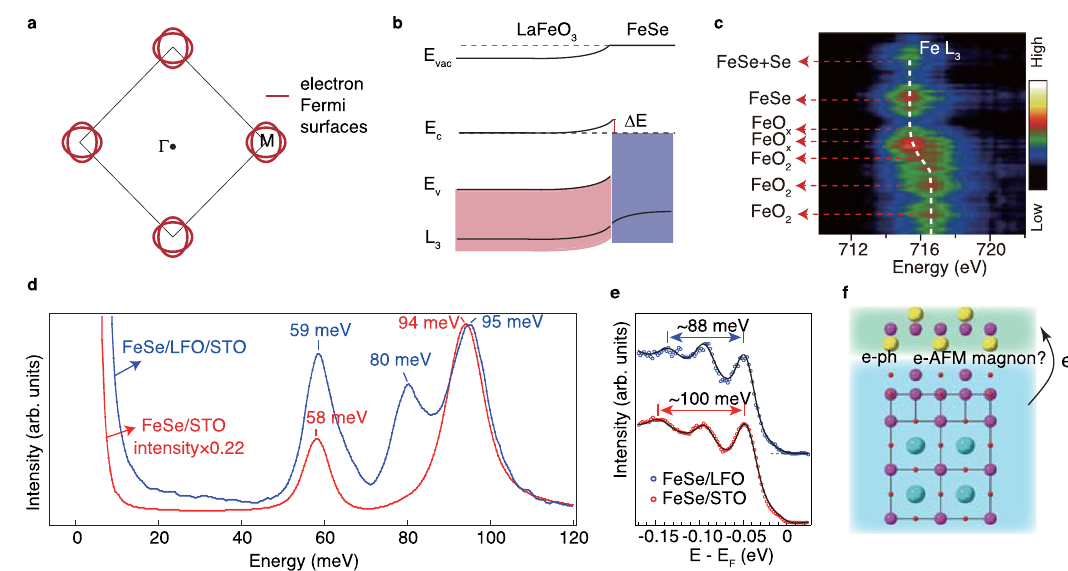
Fig. 4 Interfacial charge transfer and electron – phonon interactions. a Illustration of the measured Fermi surfaces of 1uc FeSe/LFO/STO. The Fermi surfaces consist of only electron pockets without hole pockets. b Sketch of the work function difference and band bending. c Core level EELS map near Fe L 3 edge across the interface for the 1.5uc FeSe/LFO/STO measured in Fig. 1. The dash lines mark the peak positions of the individual EELS spectrum. d High- resolution electron energy loss spectra of the 1.5uc FeSe/LFO/STO, which is compared with the data on 1uc FeSe/STO (Song et al. 19 ). After the total intensity is normalized by the elastic peak, the red line is scaled by a factor of 0.22. e EDCs at M of FeSe/LFO and FeSe/STO, which are integrated over the momentum range indicated by blue box in Fig. 2d. The data of FeSe/STO in panels d and e are reproduced from Song et al. 19 . f Sketch of the interfacial interactions which can help enhancing the superconductivity at FeSe/LFO